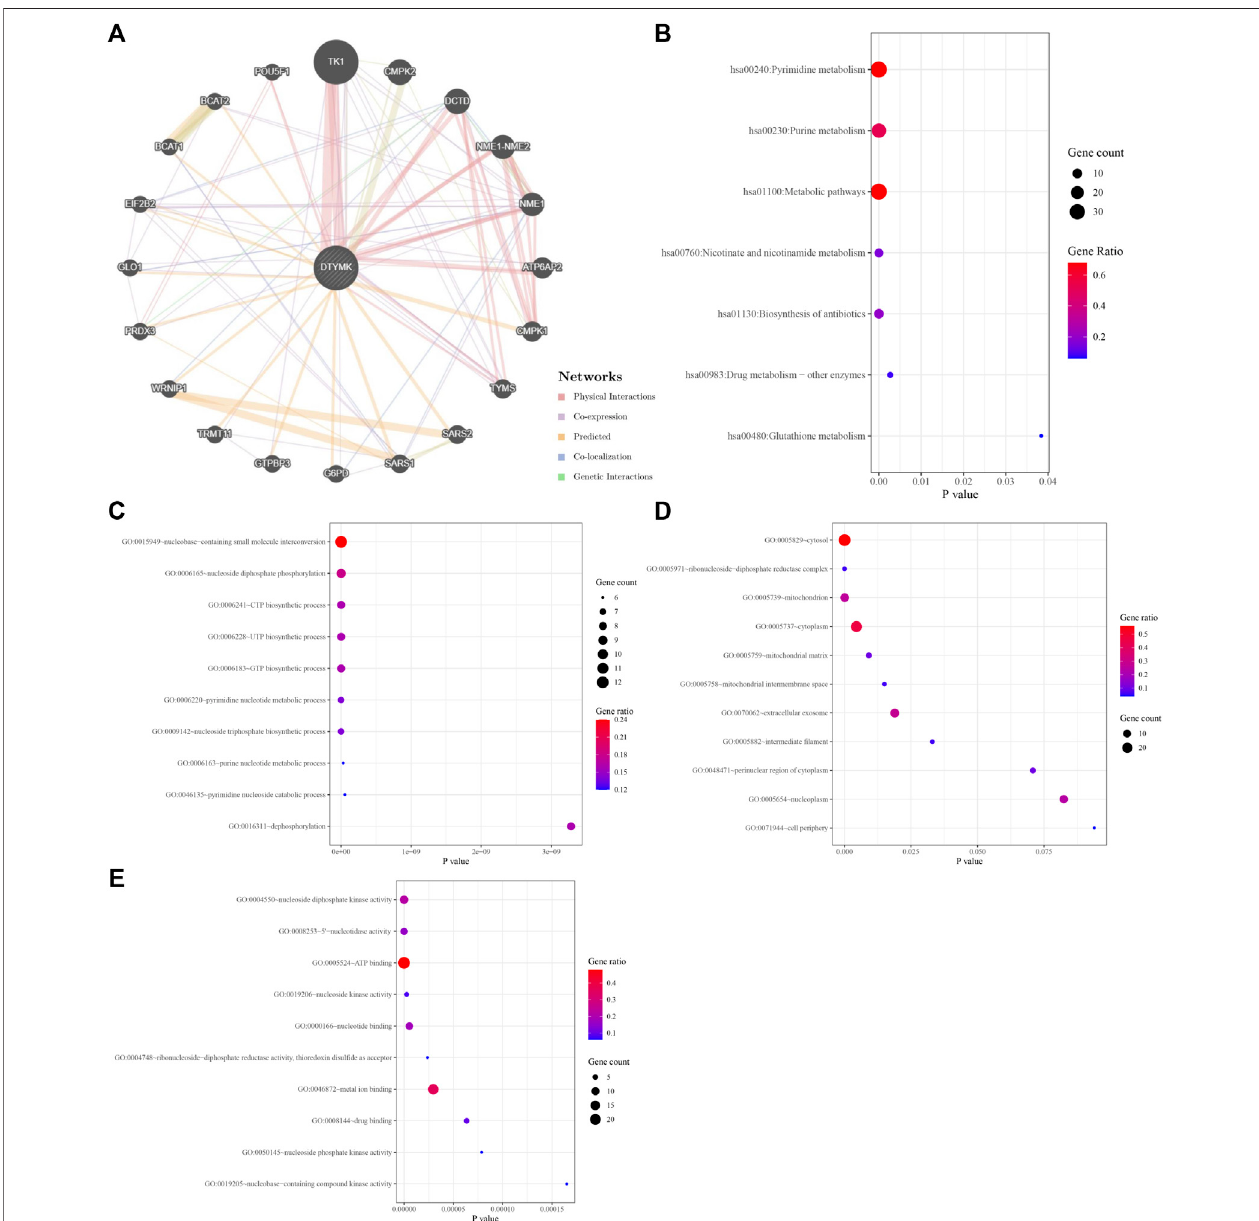
FIGURE 7 | Interactive genes of DTYMK and gene ontology (GO) analysis. (A) DTYMK interacted with TK1 and other genes in GeneMANIA database. Top 50 interactivegenesofDTYMKwereobtainedfromSTRING database andprocessedforKyotoEncyclopediaofGenesandGenomes(KEGG)analysis (B) .GOenrichment analyses include biological process (C) , cellular component (D) , and molecular function (E) by DAVID platform.